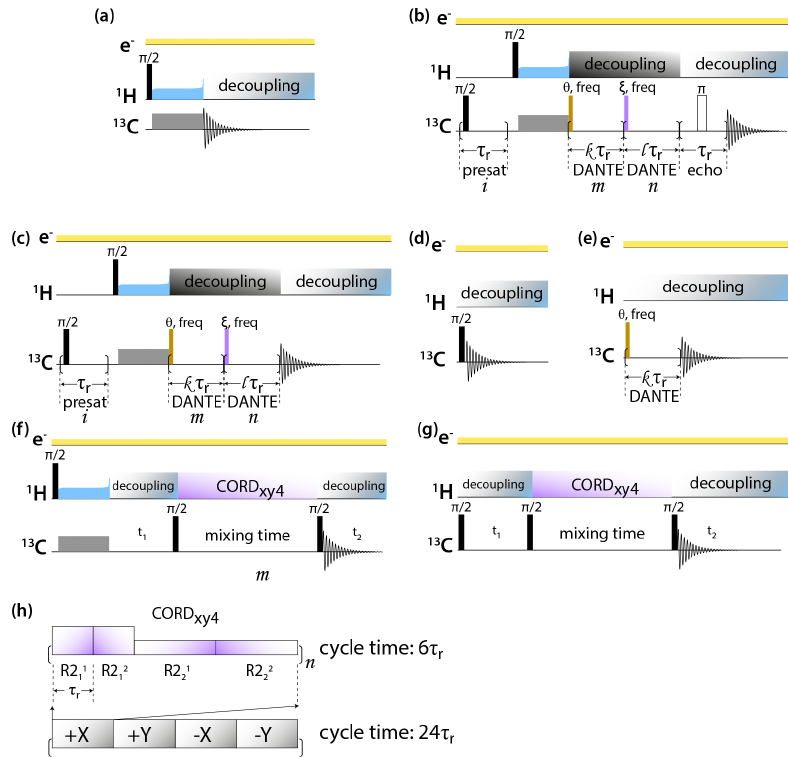
Figure 1. Pulse sequences for DNP-enhanced MAS NMR experiments: (a) CPMAS, (b) CPMAS with presaturation, selective DANTE flip and readout, and Hahn echo detection, (c) CPMAS with presaturation and selective DANTE flip and readout, (d) direct polarization, (e) direct polarization with selective DANTE excitation, (f) 2D CP-CORD xy4 , and (g) DP-CORD xy4 . (h) CORD xy4 mixing block.